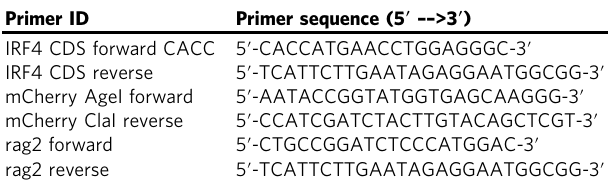
Table 1 Primer sequences used for genotyping